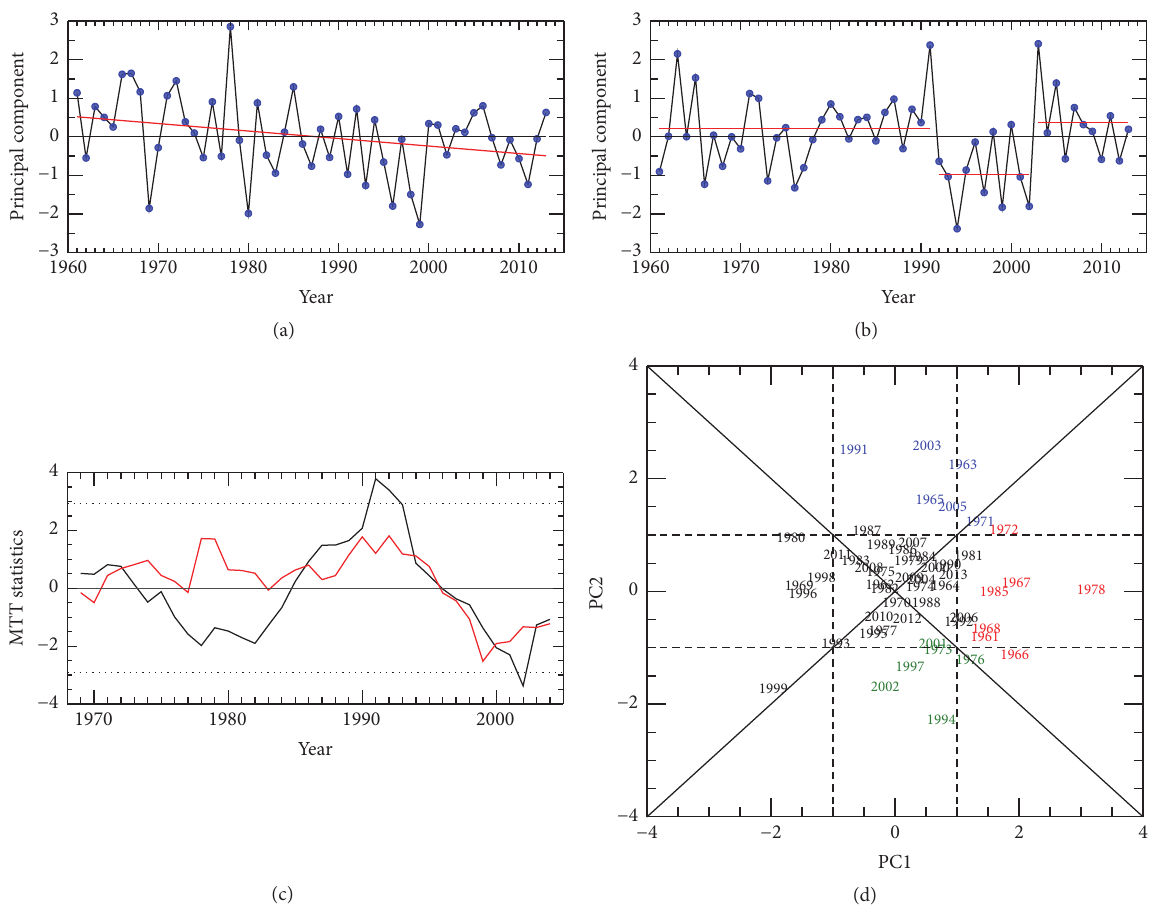
Figure 3: The normalized principal components (PCs): (a) PC1 and (b) PC2. (c) The moving 𝑡 test (MTT) of the first two PCs, in which red (black) solid line indicates MTT statistics of the PC1 (PC2) and dotted lines indicate 99% confidence level. (d) The scatter diagram of the PC1 versus PC2 for 1961–2013, in which the WBWD, SDNF, and SFND years are colored in red, blue, and green, respectively. Red line in (a) denotes trend line of PC1, significant at 95% confidence level for the Mann-Kendall trend test, and red lines in (b) denote mean value